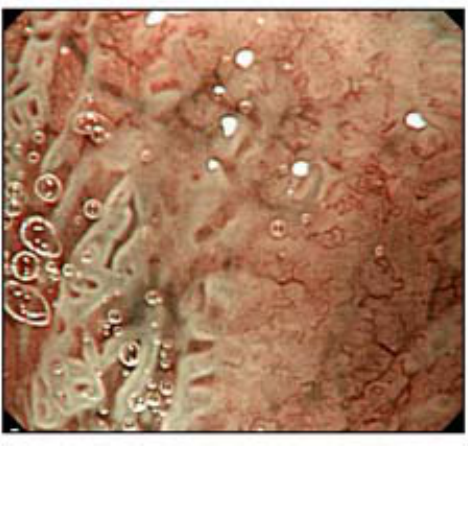
FIGURE 6. Esophagus, Barrett: Intestinal metaplasia; narrow-band imaging coupled to magnification. The epithelial crests show a ridged pattern